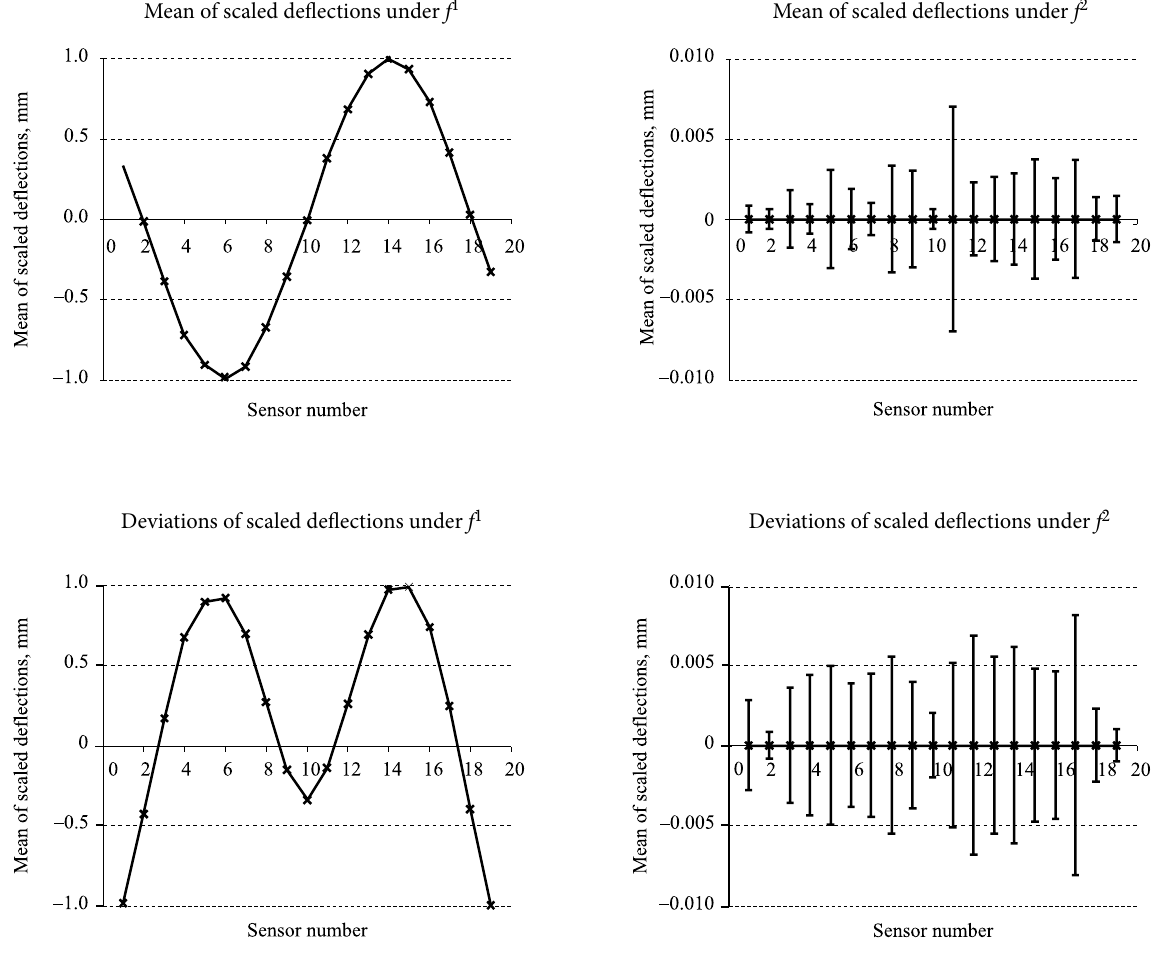
Fig. 11. Mean deflections and their deviation level under PBILs